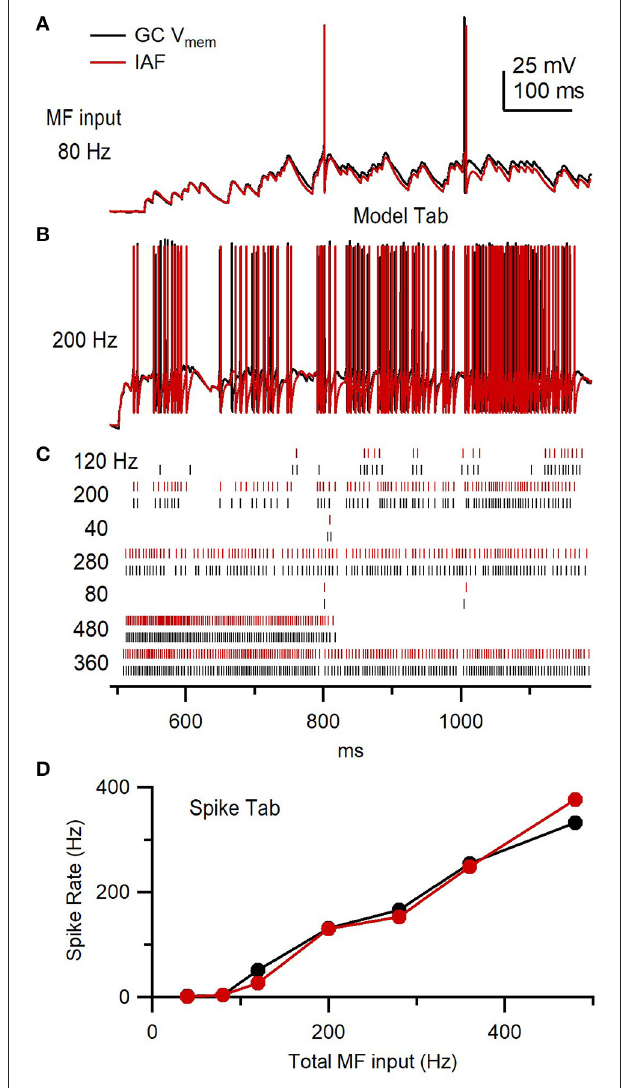
FIGURE 15 | Granule cell versus integrate-and-fire model response to the same simulated synaptic conductance trains. (A) GC membrane potential (V mem ) from Figure 14C (black) compared to an IAF model response (red) to injection of the same G AMPAR and G NMDAR waveforms (80Hz total MF input rate) and tonic G GABAR . The IAF response was computed using NeuroMatic’s Model tab as described in Supplementary Figure 6. (B) Same as (A) but for G AMPAR and G NMDAR computed with 4 simulated MF inputs with f = 50Hz (i.e., 200Hz total MF input rate) via the Pulse tab. (C) Spike raster plots computed from V mem responses in (A,B) , and 5 other responses for different f , using the Spike tab. The total MF input rate is denoted on the left. (D) Output spike rate versus total MF input rate using data in (C)